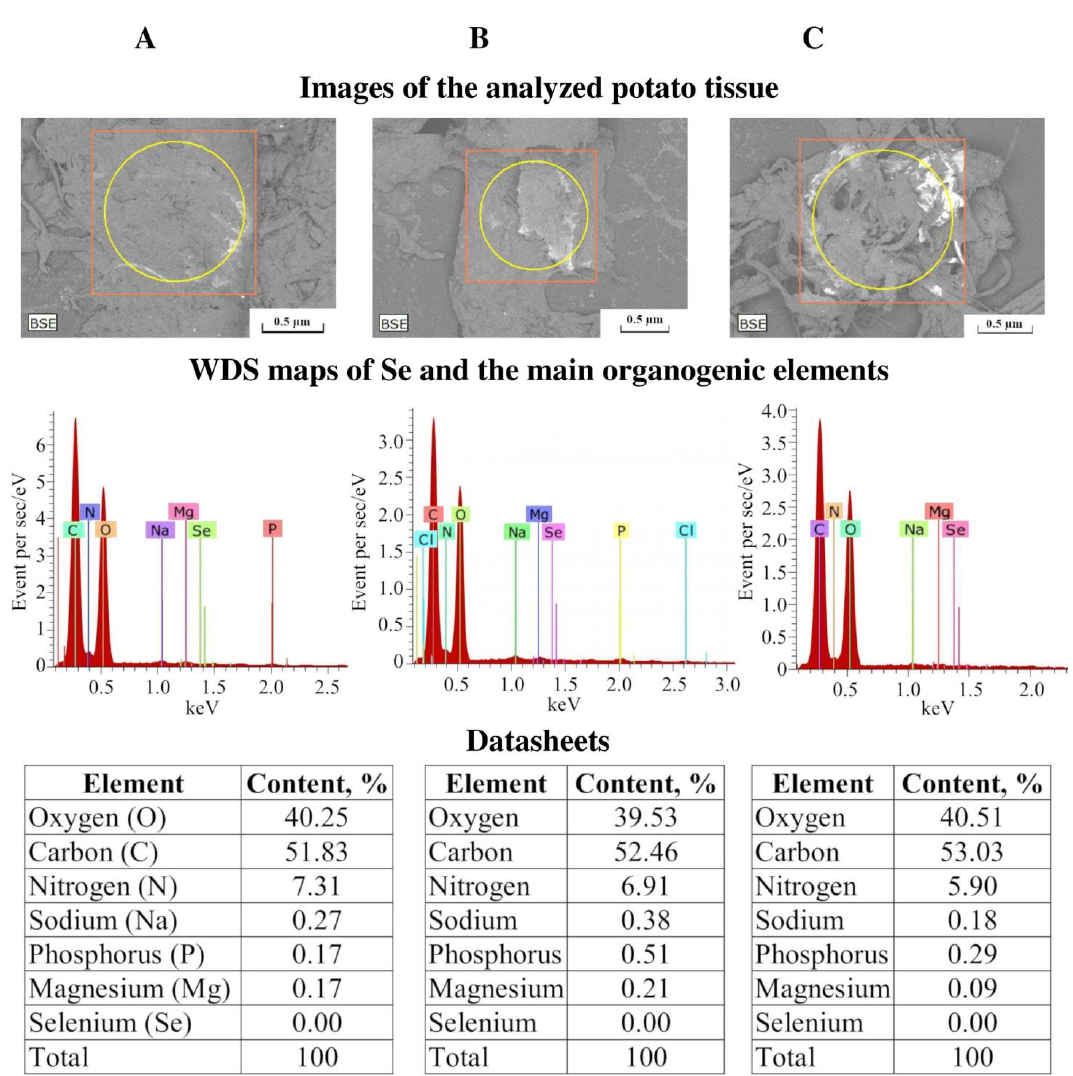
Figure 6. Results of energy-dispersive X-ray spectroscopy microanalysis (EDXMA) of infected Cms potato plant tissues (variety Lukyanovsky) untreated ( A ) and treated with Se/ST ( B ) or Se/AG ( C ) NCs. WDS—Wavelength-Dispersive Spectroscopy. Shown as an example of typical data from one of the experiments.